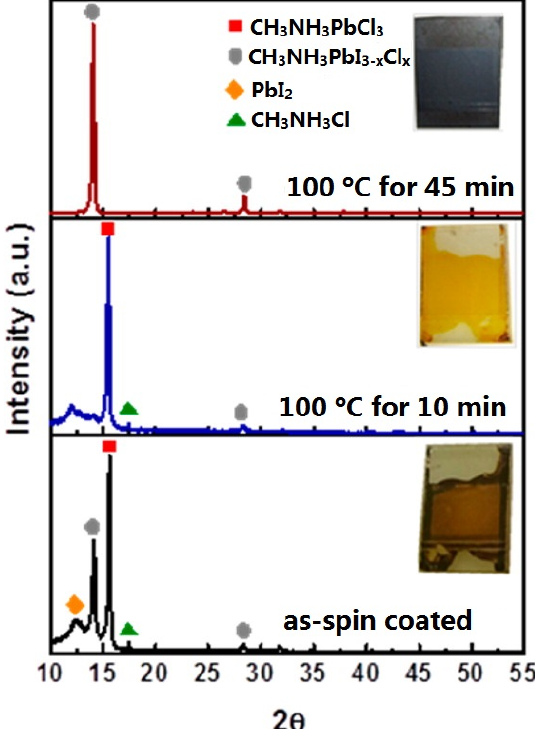
Figure 4. XRD patterns and optical images (insets) of MAPbI 3 ‐ x Cl x film during annealing. Reprinted from reference [84], Copyright © 2015, American Chemical Society.